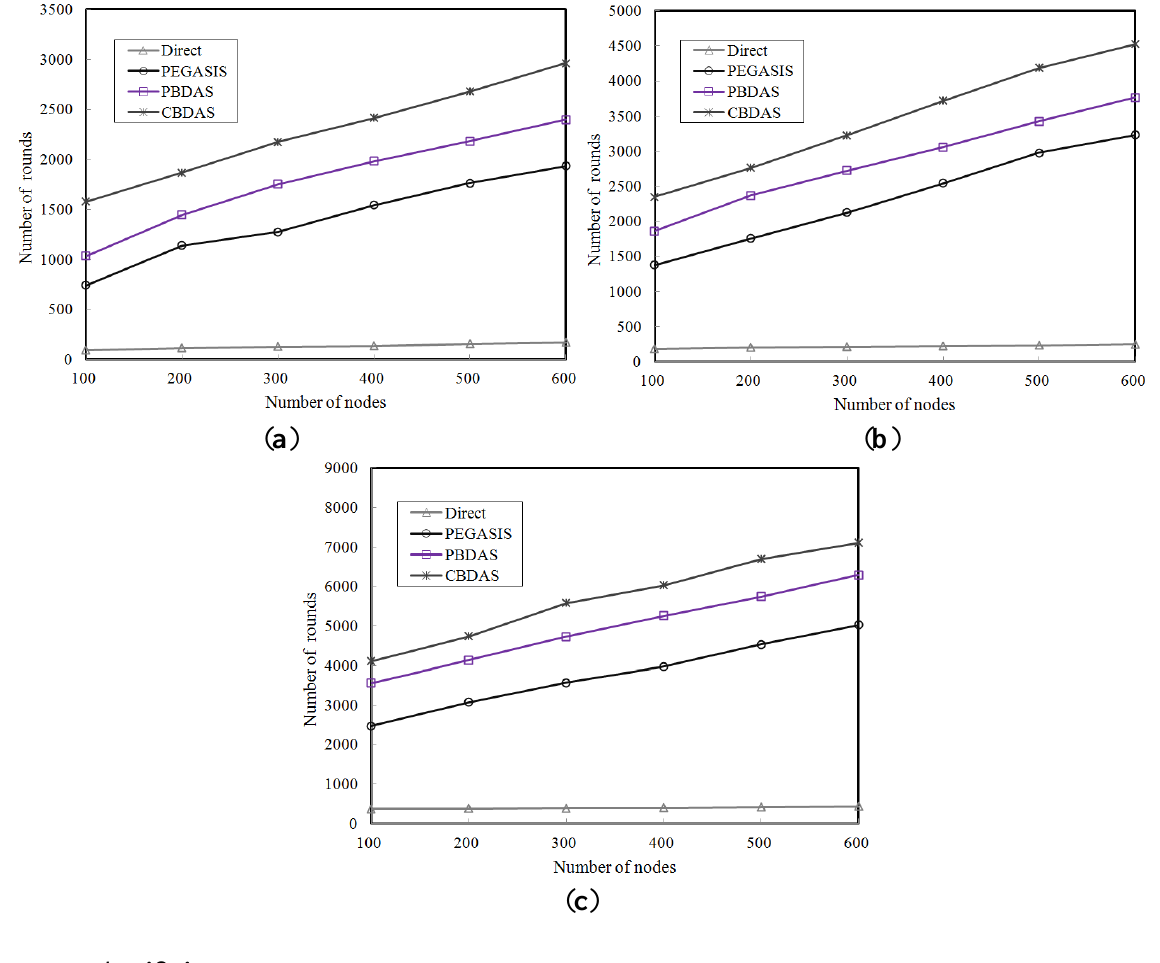
Figure 7. Impact of node density. ( a ) Each node with initial energy 0.25 J; ( b ) Each node with initial energy 0.5 J; ( c ) Each node with initial energy 1.0